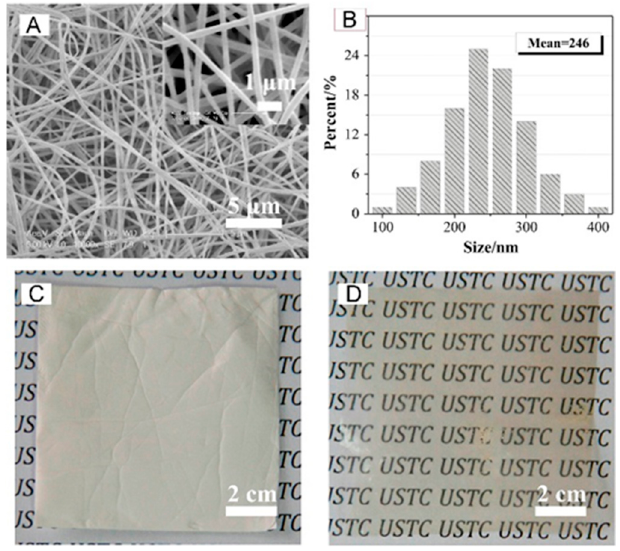
Figure 10. SEM images ( A ) and fiber diameter distribution ( B ) of QPPO–SiO 2 ; optical photographs of nanofiber mats ( C ) and membrane ( D ) after hot-press. Reproduced with permission from Ref. [102]. In a simulated polishing waste solution containing 1 M HCl and 0.225 M FeCl 2 ,